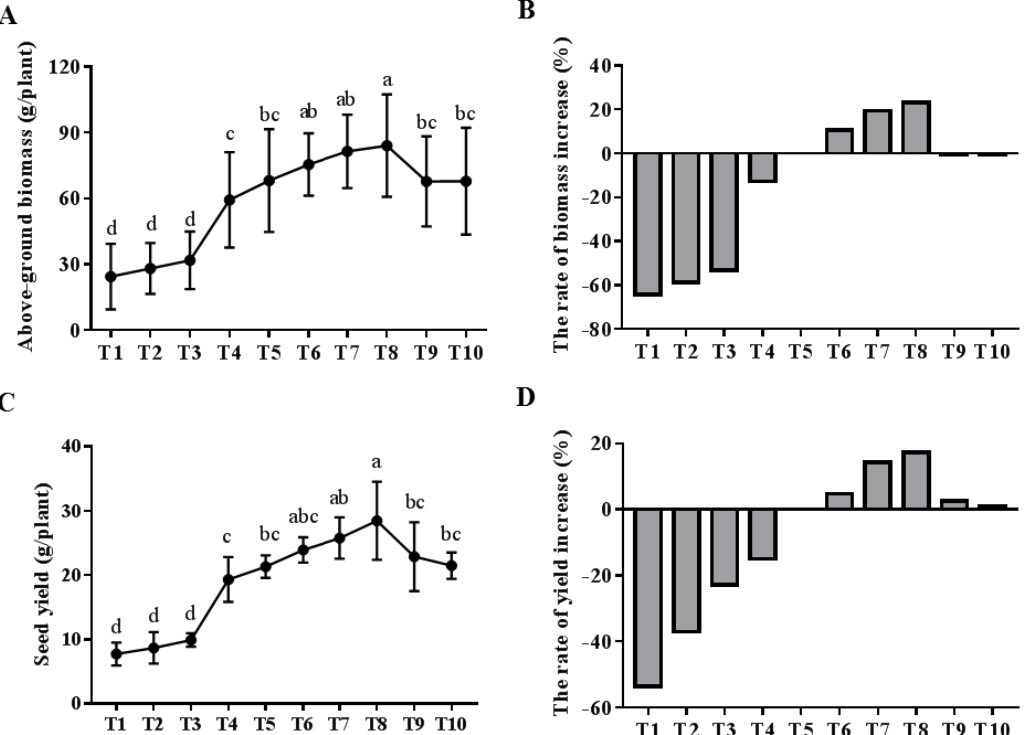
Figure 8. The above-ground biomass and seed yield of Brassica napus at the mature stage under di ff erent CMS treatments. Ten di ff erent treatments (T1-T10) were conducted in the field trials. No fertilizer was applied in T1 treatment. T2, T3, and T4 were treated with 50, 200, and 500 g m − 2 CMS before sowing without any chemical fertilizers, respectively. Normal chemical fertilization without any CMS were applied in T5. For T6 and T7 treatments, chemical fertilizers together with 50 and 200 g m − 2 CMS were applied before sowing, respectively. For T8, T9, and T10 treatments, normal chemical fertilization was applied, while 200 g m − 2 CMS were applied at seedling, bolting, and flowering stages, respectively. ( A ) Above-ground biomass; ( B ) Seed yield; ( C ) The rate of biomass increase; ( D ) The rate of yield increase. Di ff erent letters indicate the significant di ff erences at a p < 0.05 by Duncan’s test. Data are means ± SD from 16 individuals. Table 3. Yield-related traits of Brassica napus under different treatments in the field trial. Treatments